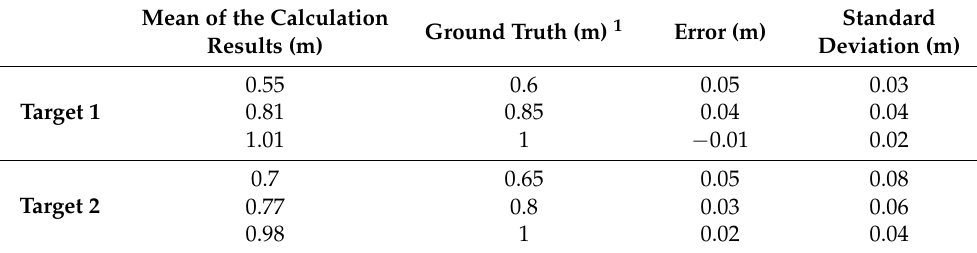
Table 1. Calculated distance results for both targets. Table 2. Vital sign results for both